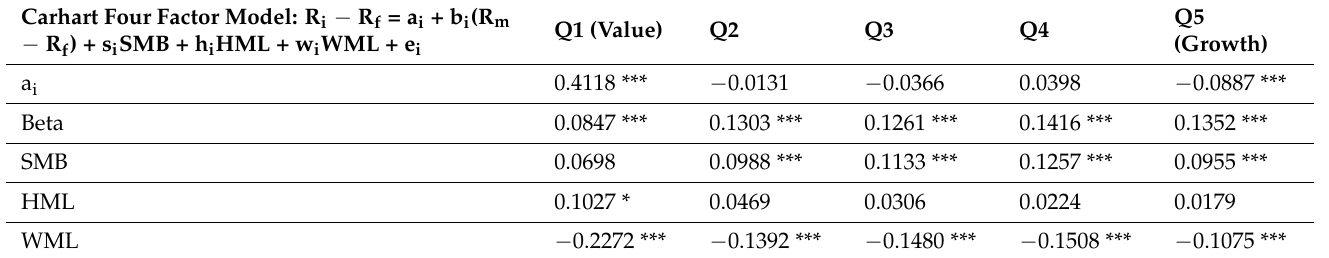
Table 8. Robustness check for Value and Growth REIT portfolios